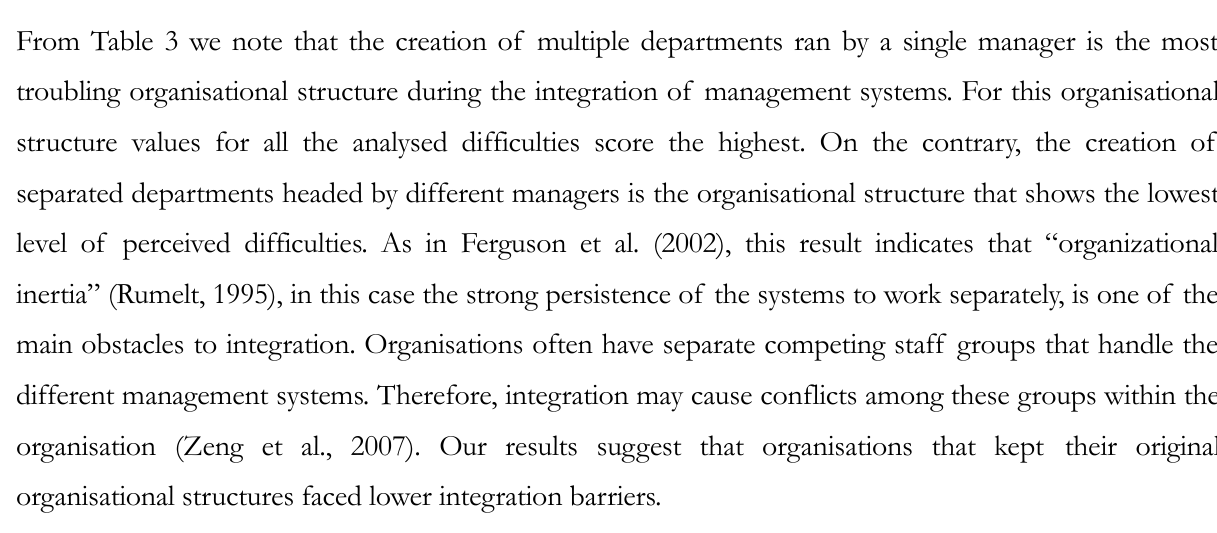
Table 3. Descriptive statistics for the difficulties according to the organisational structure of the